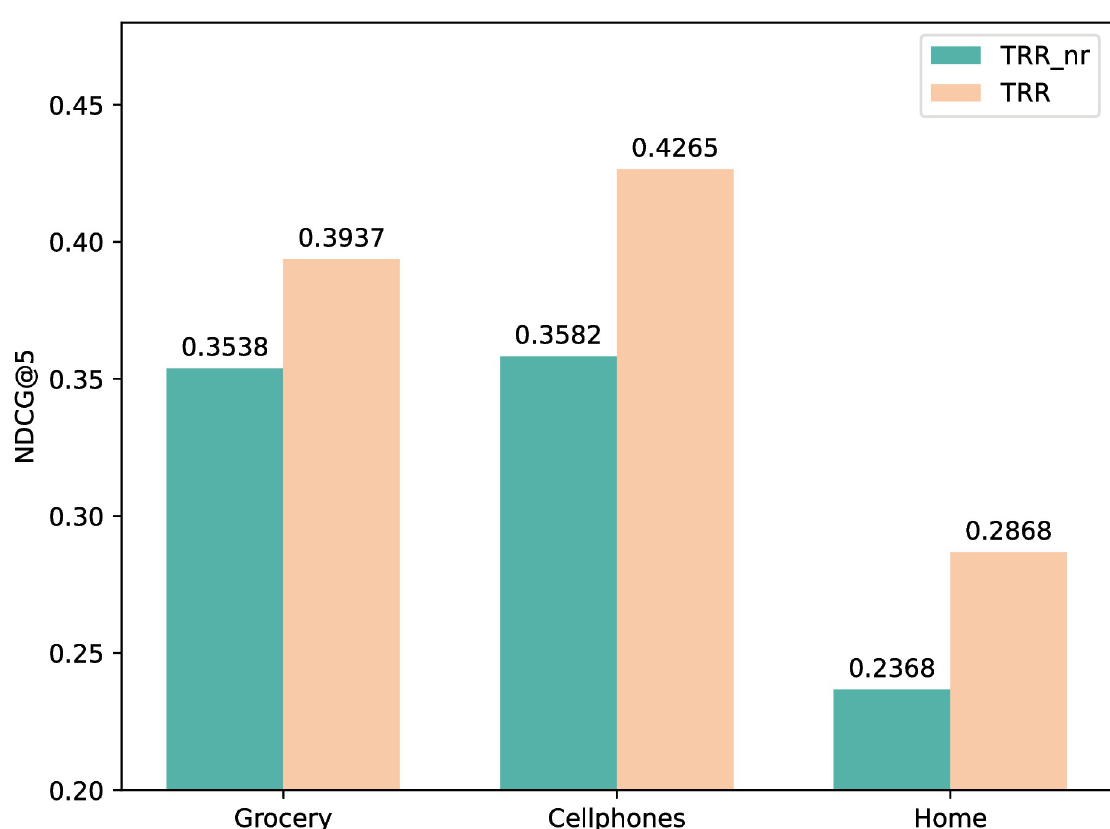
Fig 3. The impact of the target-relation regulated representation learning (NDCG@5).